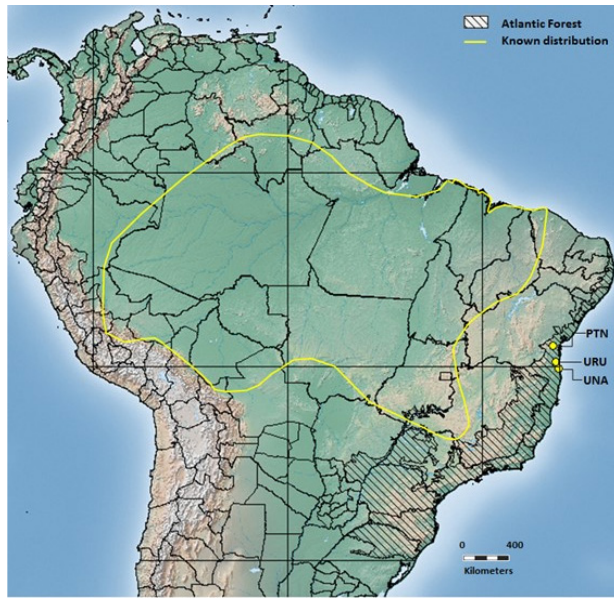
Forest (diagonal lines). PTN = municipality of Presidente Tancredo Neves in upper portion of the south of the state of Bahia; URU = municipality of Uruçuca and UNA = municipality of Una, both located in southern portion of state of Bahia. These records broaden the known distribution of the species (in yellow) proposed by Camargo and Pedro